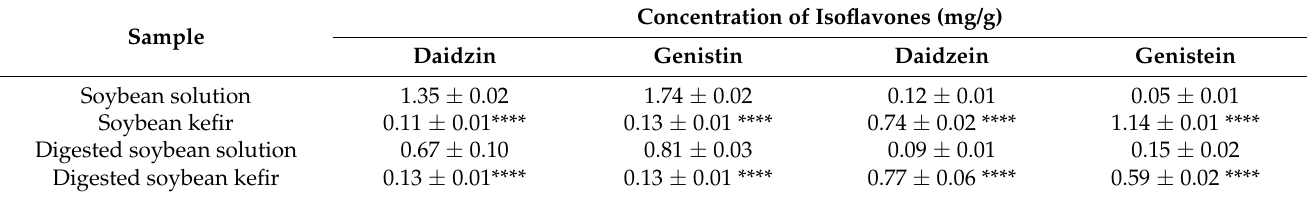
Table 1. Concentrations of isoflavones in soybean solution, soybean kefir, digested soybean solution, and digested soybean